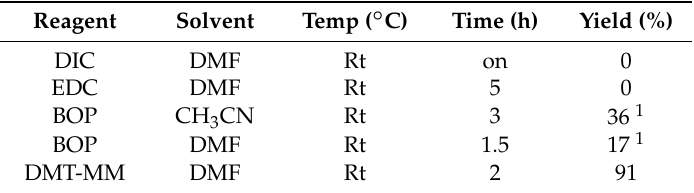
Table 1. Results of the coupling reaction of AMN-Str 3 and biotin.